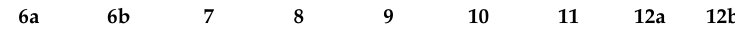
Table 6. The Spearman correlation coe ffi cients ( rho ) for each National Institutes of Health Stroke Scale (NIHSS) feature of the Korean